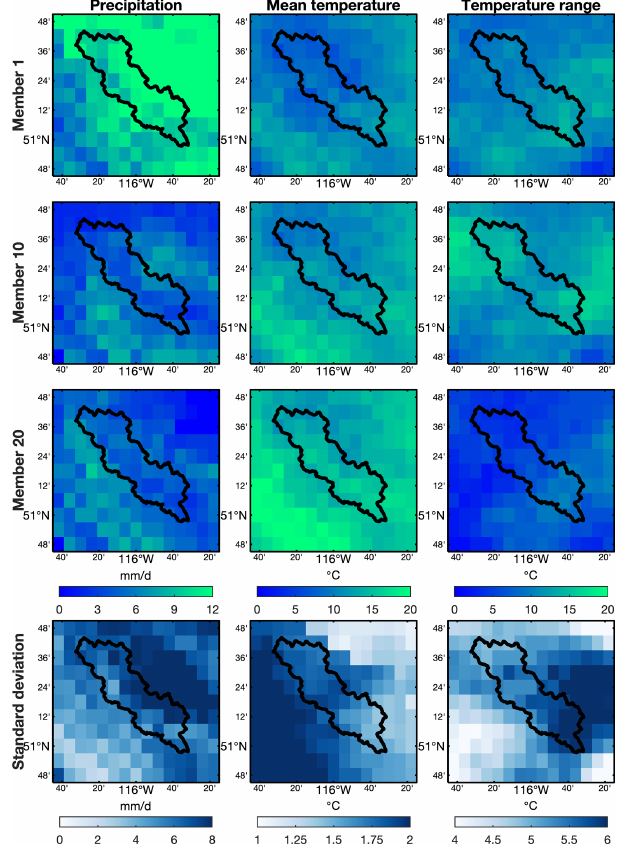
Figure E1. The distributions of daily precipitation (the first col- umn), mean daily temperature (the second column), and daily tem- perature range (the third column) on 29 June 2015. The first to third rows represent ensemble members 1, 10, and 20, respectively. The fourth row represents the standard deviation of 25 members for this day. The black line outlines the Bow River basin above Banff,